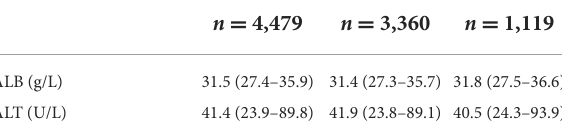
TABLE 2 Comparison of demographics, clinical and laboratory data between the non-PVT group and PVT group in the training set.